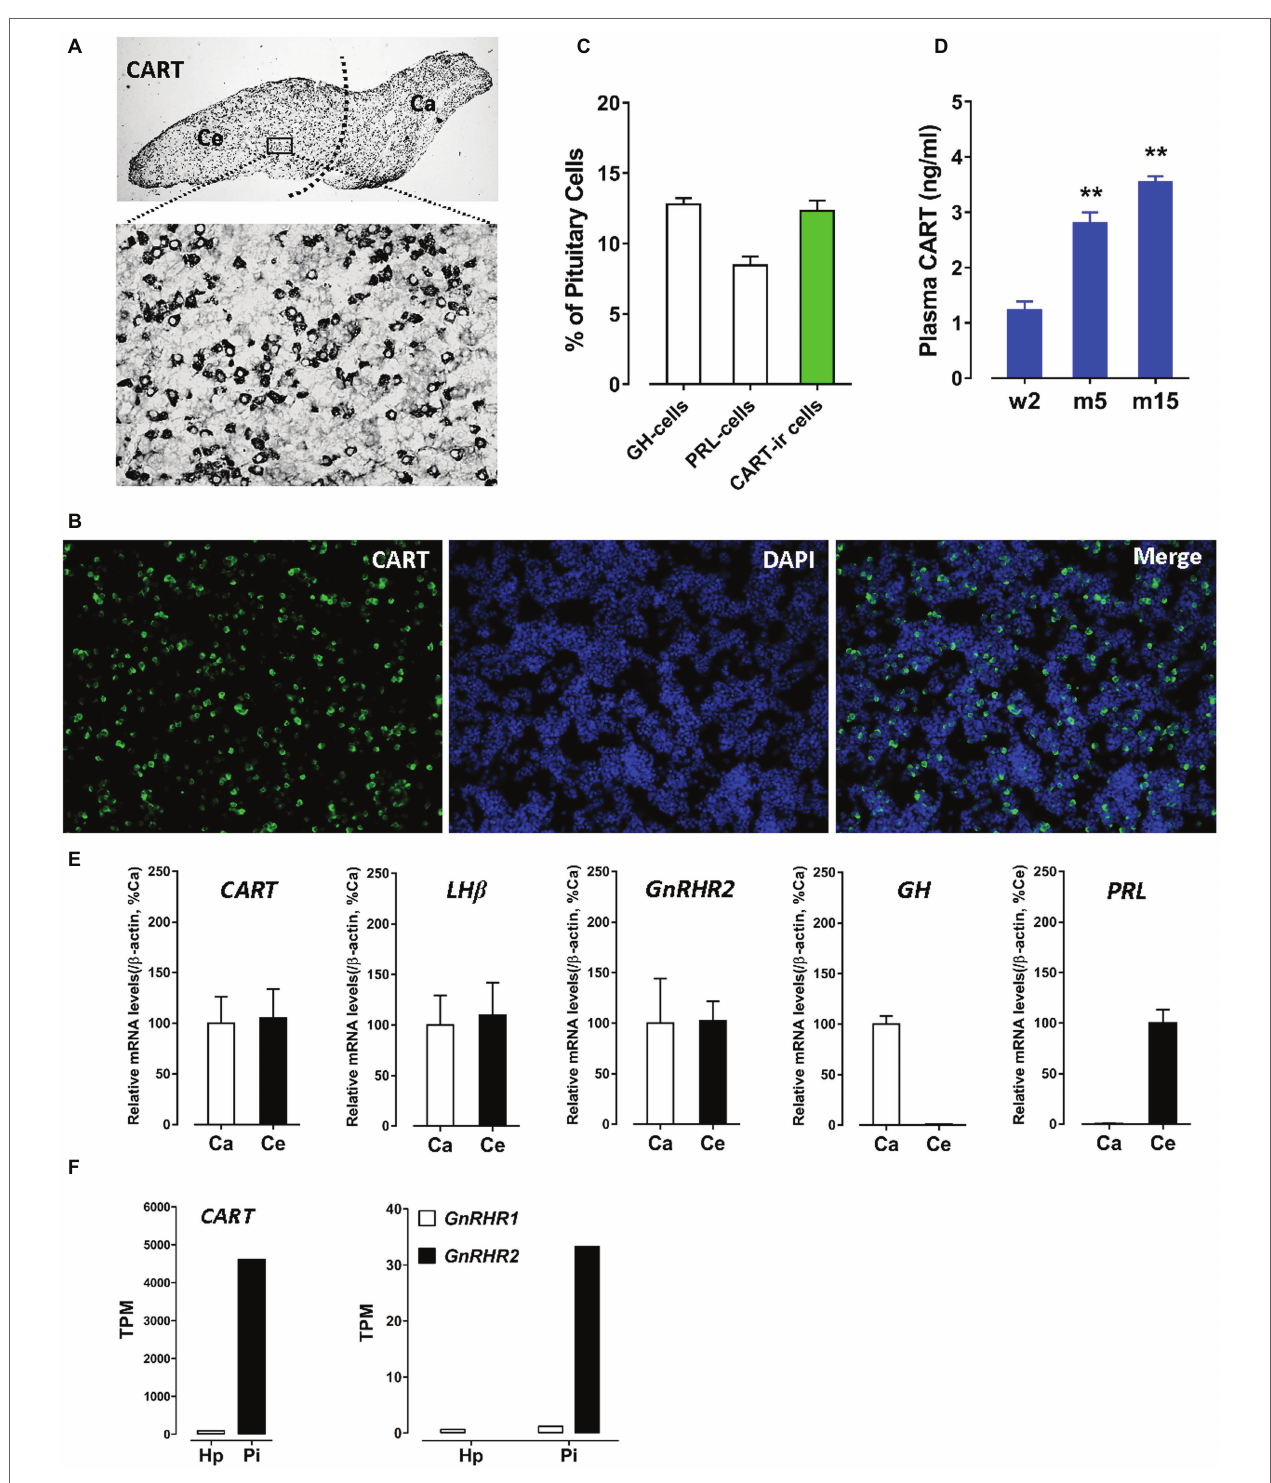
FIGURE 1 | (A) Immunohistochemical staining of cocaine- and amphetamine-regulated transcript (CART) in the anterior pituitary of adult male chickens. Histological examination was performed under bright-field illumination with a magnification at 40× (upper panel) and 400× (lower panel). CART-ir cells were found to be densely distributed in the cephalic (Ce) and caudal (Ca) lobes of anterior pituitaries. (B) Immunofluorescence staining of CART signal (green) in short-term cultured dispersed pituitary cells of adult male chickens. (C) Graph shows the relative proportion (positive cells/DAPI-stained nuclei %) of GH-cells (~12.8%), PRL-cells (~8.5%), and CART-ir cells (~12.3%) in short-term cultured dispersed pituitary cells. Each data point in graphs represents mean ± SEM of four replicates ( N = 4).